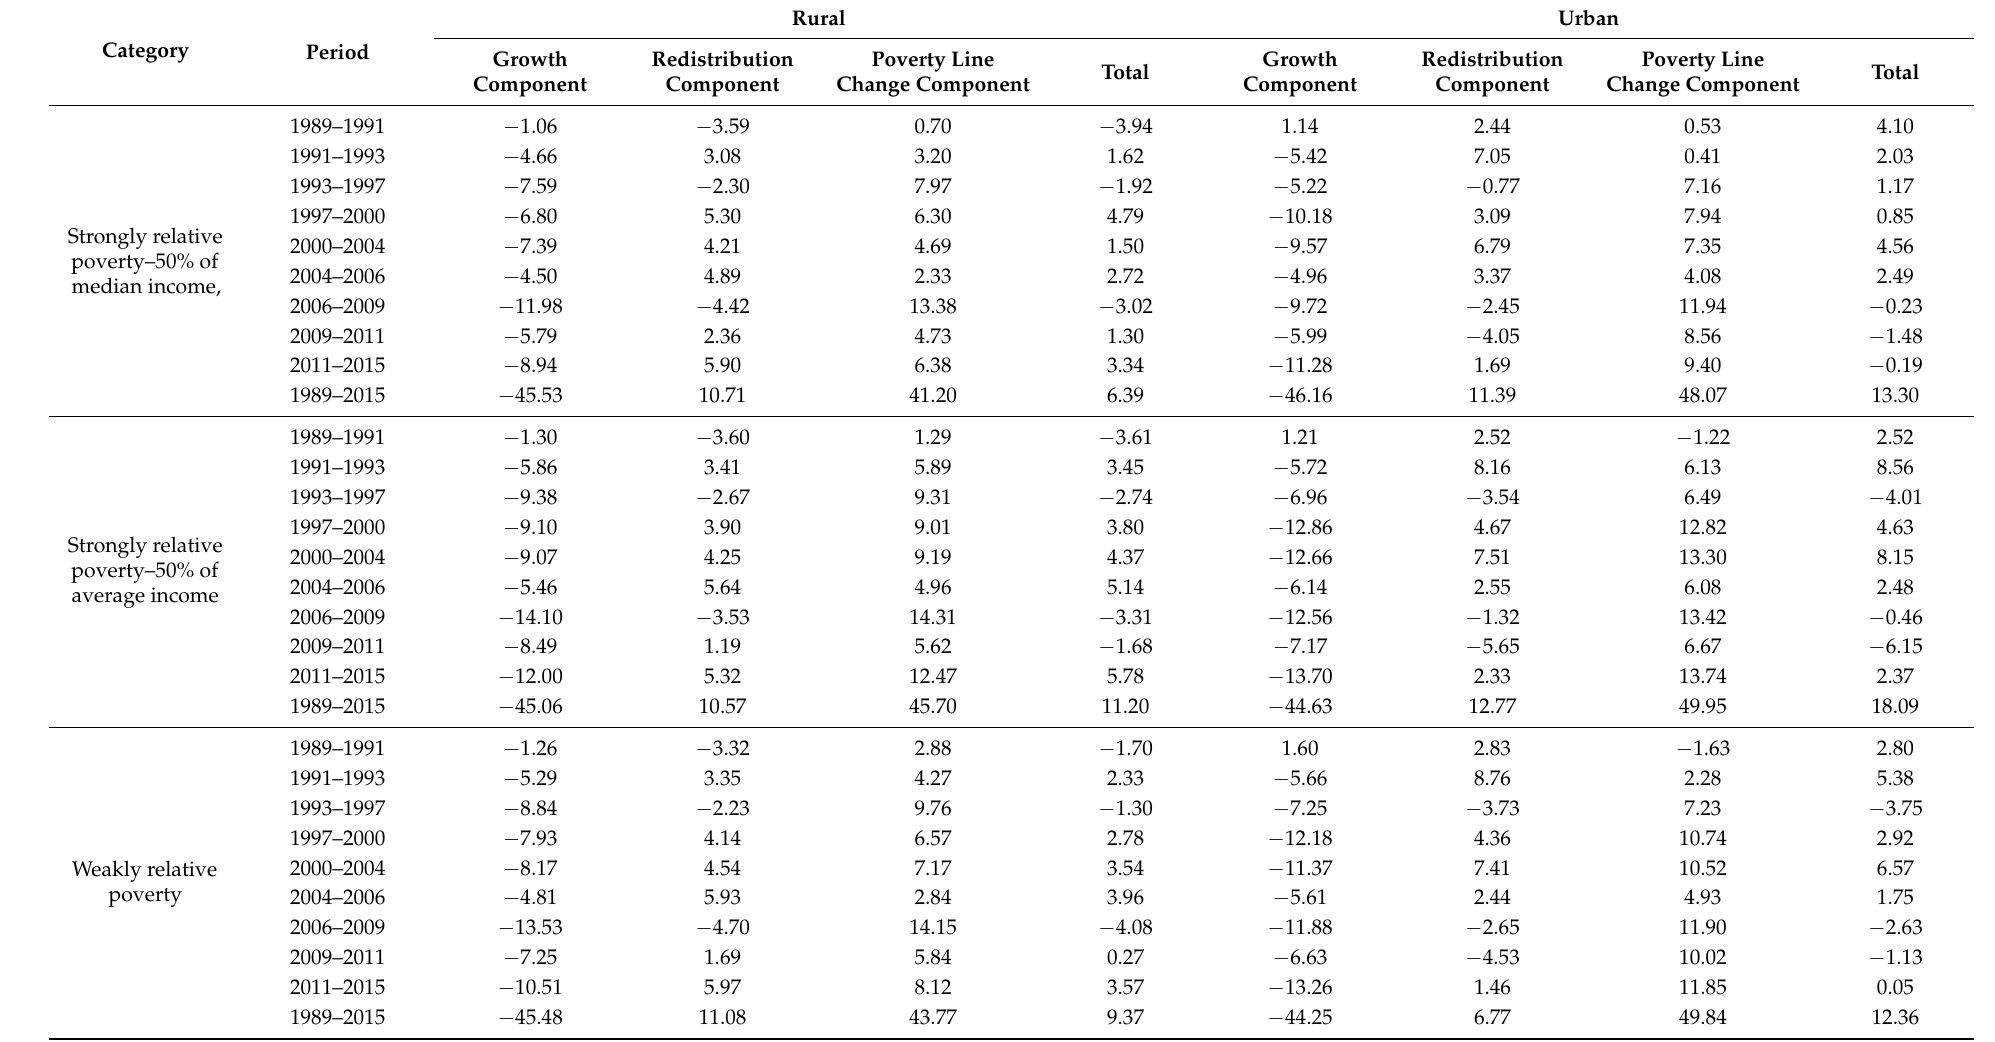
Table 7. Decomposition of relative poverty change between urban and rural areas